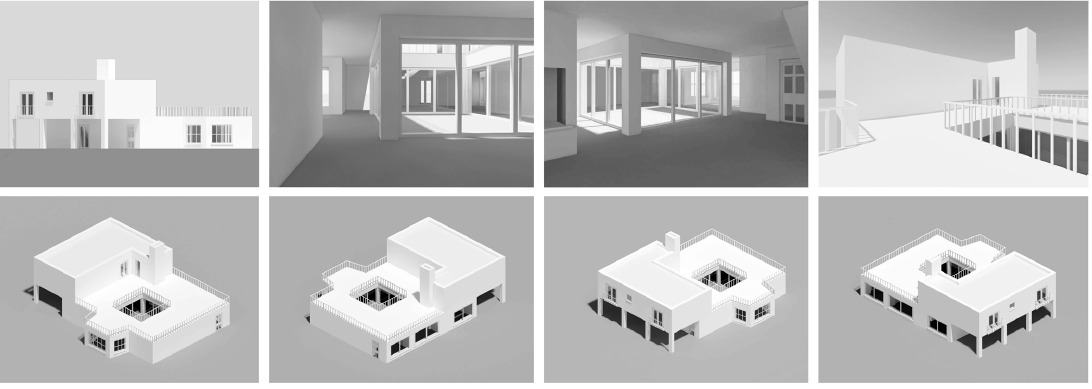
Figure 12. House 10. Axonometric views and perspectives (C. Gelardi).